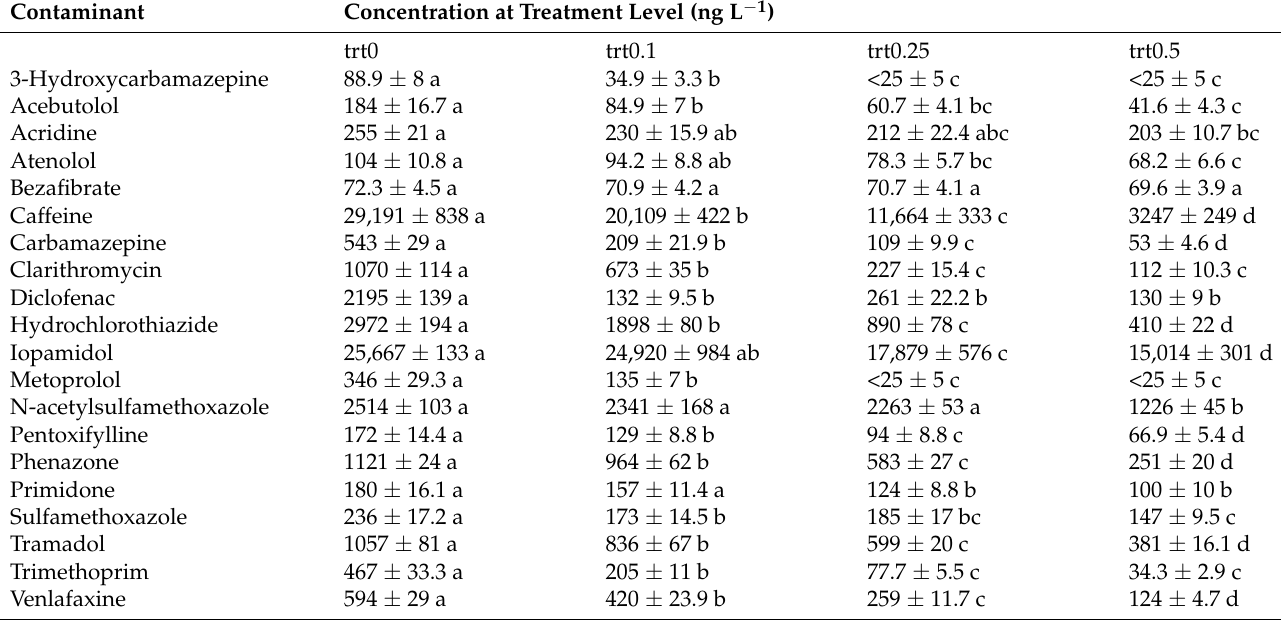
Table 3. Pharmaceuticals concentrations after biochar addition at different concentrations (0, 0.1, 0.25 and 0.5 g L − 1 ). Values represent means ± standard deviations. Different letters refer to significant differences between the values (Tukey HSD test, n = 3, p ≤